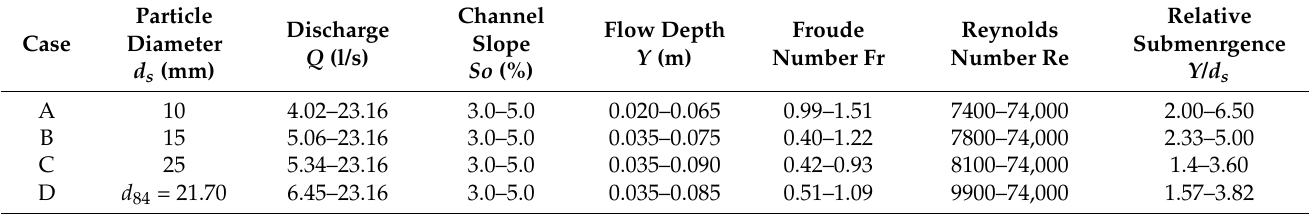
Table 2. Simulation